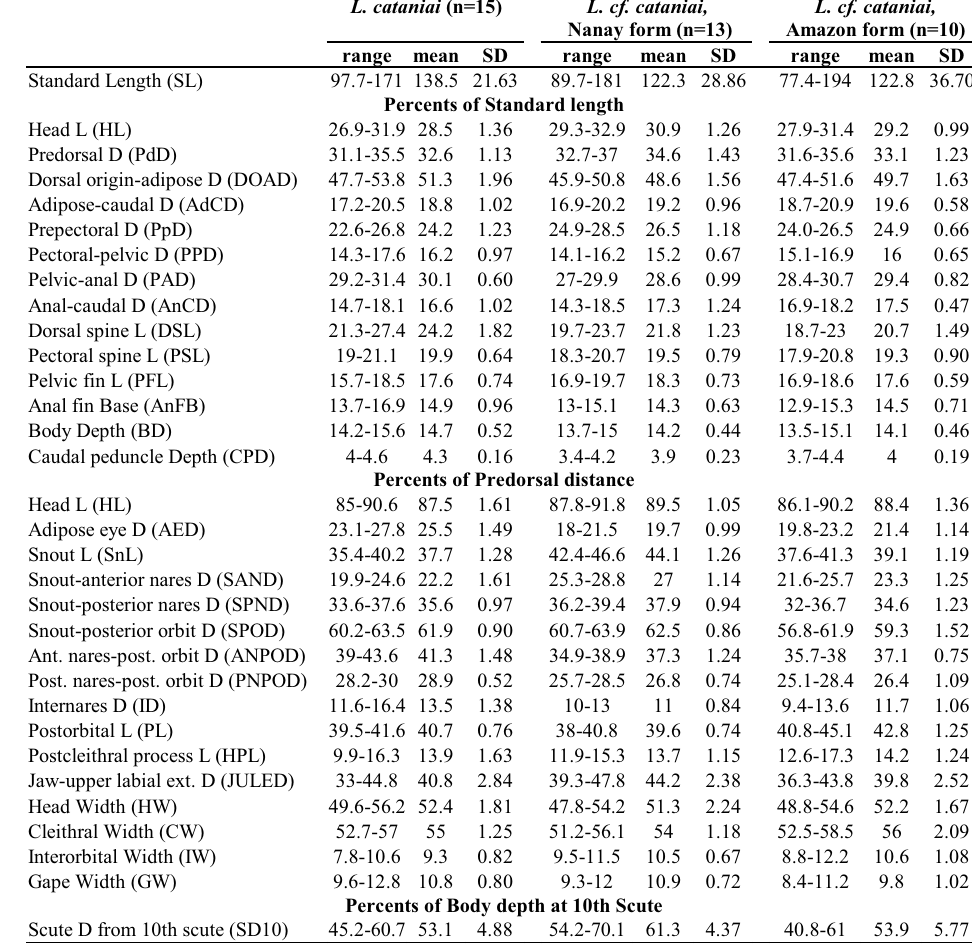
Table 2. Morphometrics of Leptodoras cataniai , L. cf. cataniai (Nanay form) and L. cf. cataniai (Amazon form). Measured specimens denoted with asterisk in material